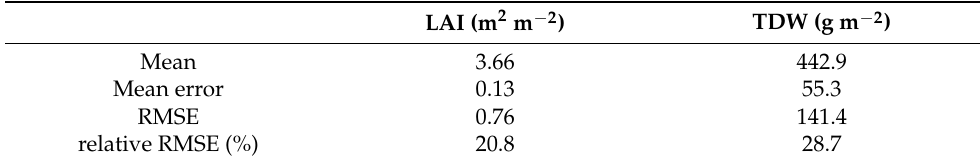
Figure 11. Relationship between the estimated and observed values of ( a ) TDW and ( b ) LAI in 2019 (Rep. 1, 2 and 3). BAS: n = 24, NIP and IR: n = 48. Table 2. Estimation accuracy of LAI and TDW in 2019 (Rep. 1, 2 and